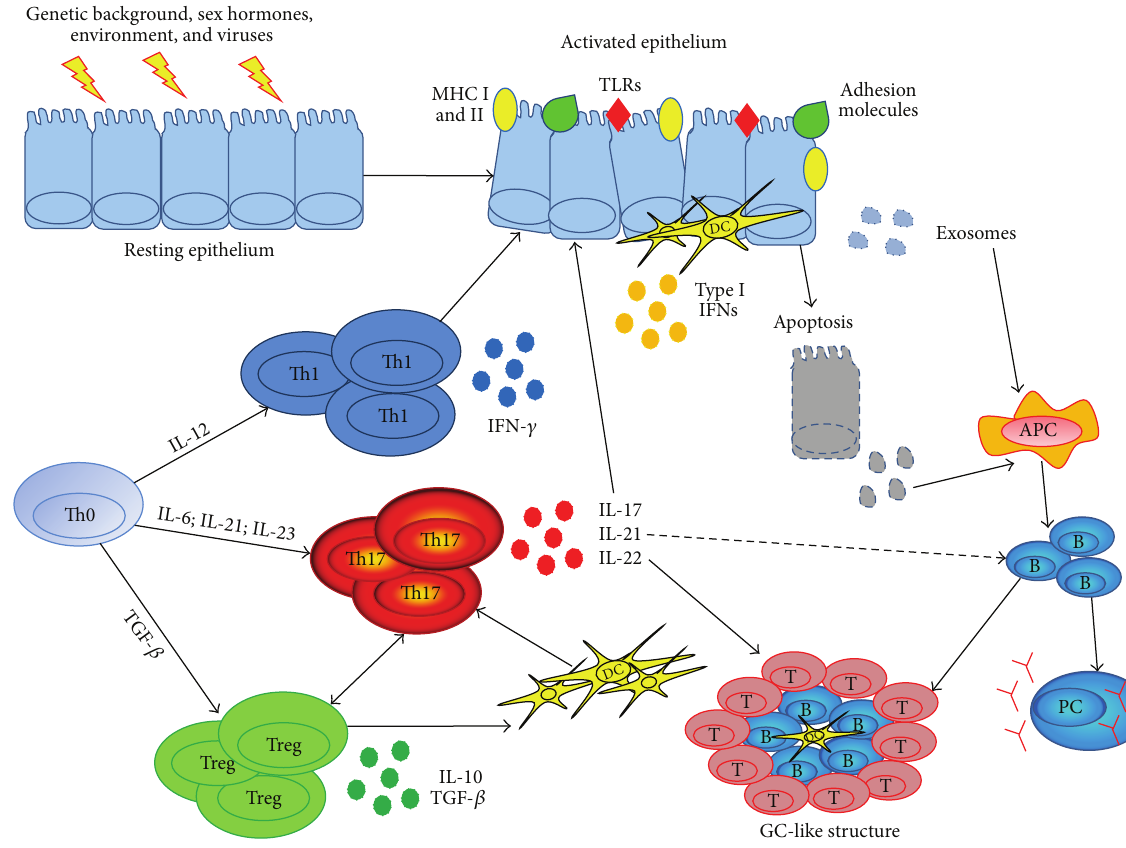
Figure 1: Cellular and molecular players in the pathogenesis of primary Sj¨ogren’s syndrome. MHC = major histocompatibility complex, TLR = toll-like receptor, DC = dendritic cell, Th = T helper cell, IFN = interferon, IL = interleukin, APC = antigen presenting cell, Treg = T regulatory cell, PC = plasma cell, GC = germinal center, TGF = transforming growth